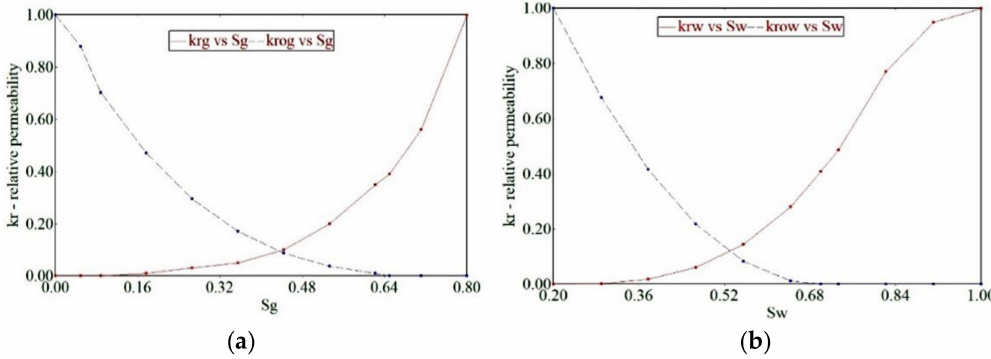
Figure 2. The end-point relative permeability for ( a ) K r vs. S g ( b ) K r vs. S w